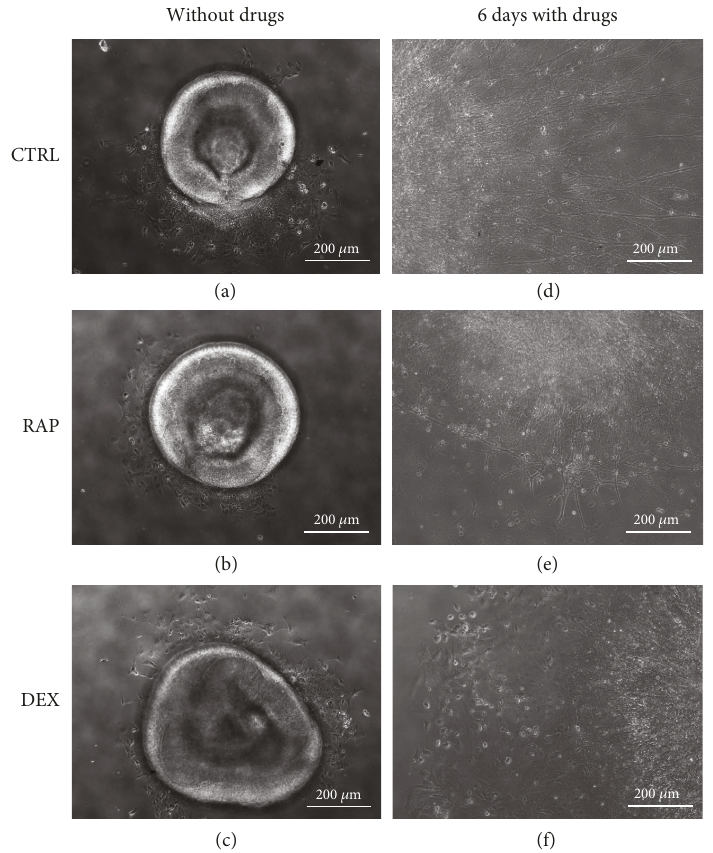
Figure 2: Morphology of retinal organoids exposed to dexamethasone (DEX) and rapamycin (RAP). Three-dimensional organoids shaped like biconcave discs were derived from human-induced pluripotent stem cells (hiPSCs). (a – c) After 4 days of adherent culture, although the organoids maintained their shapes, some cells were observed to migrate out from the organoids. Six days after culture with or without immunosuppressants, the morphologies of the retinal organoids changed. (d) Without drugs, the axons of the organoids were long, strong, and distributed radially; cells were also observed to have migrated farther away from the organoid. (e) With RAP treatment, axons were much shorter than those of cells in the control group; in addition, the axons tended to intertwine with each other at the edge of the organoid. (f) In the DEX-treatment group, long axons were very few and thin. CTRL: control group; RAP: rapamycin-treatment group; DEX: dexamethasone-treatment